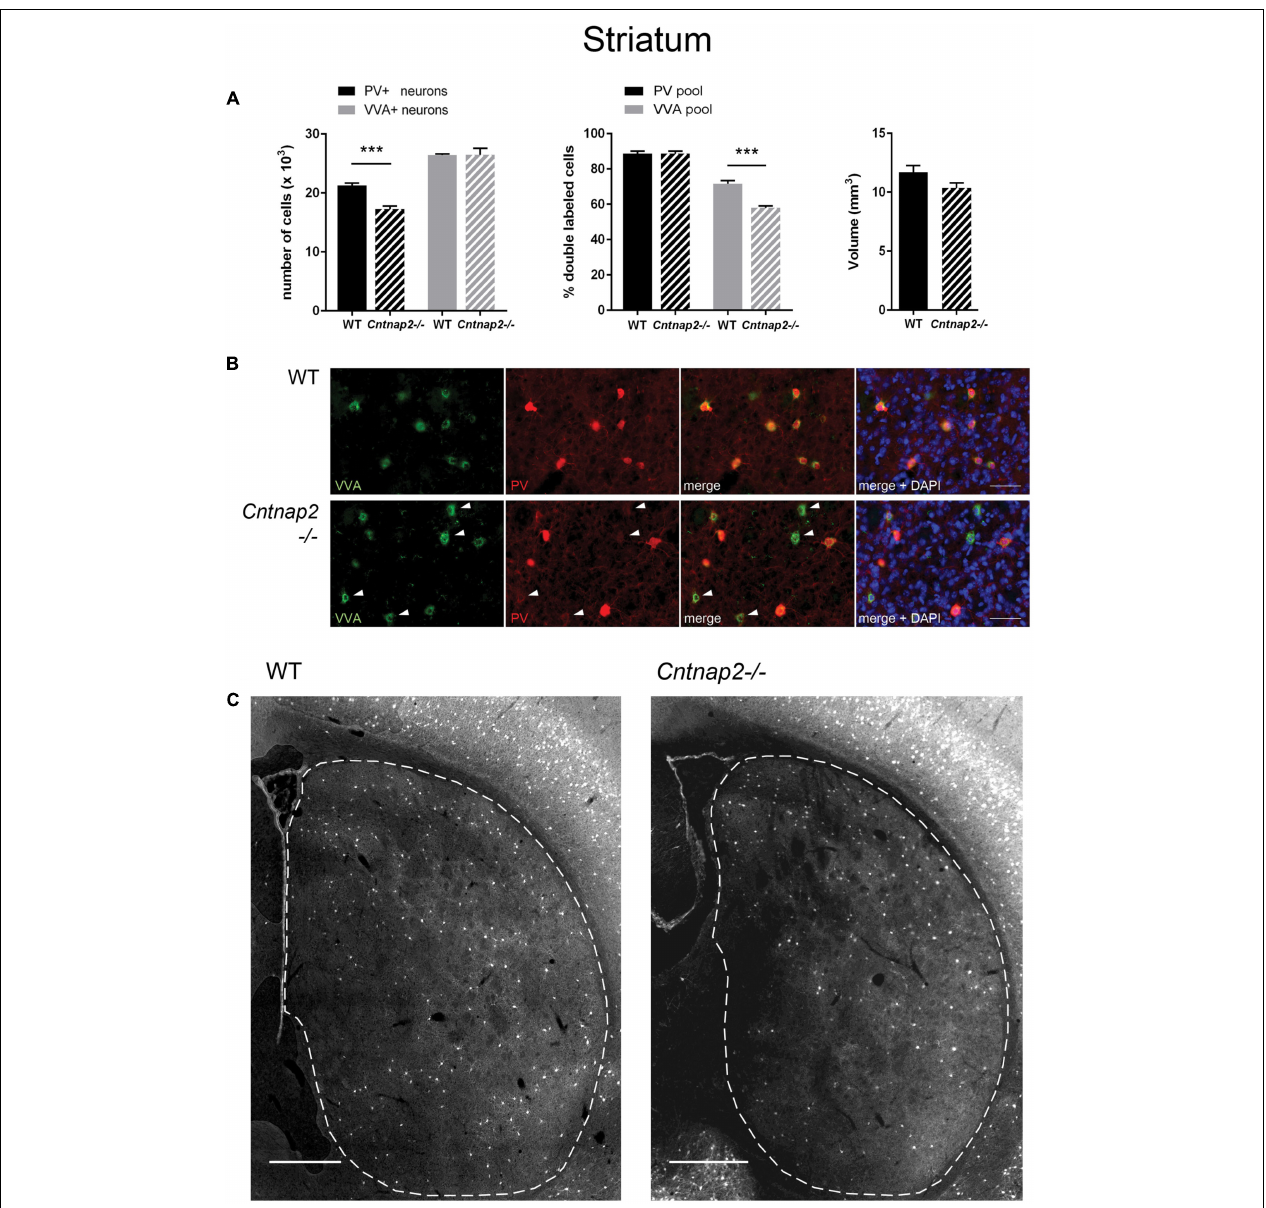
FIGURE 1 | (A) Left: Stereological estimations of PV + (black) and VVA + (gray) cells in the striatum of PND25 WT ( N = 6) and Cntnap2 − / − ( N = 5) mice. Middle: percentage of PV + cells surrounded by VVA (black) and VVA + cells showing PV expression (gray) in WT and KO mice. Right: Volume of the ROI; i.e., the striatum. Asterisks represent ∗∗∗ P < 0.001. (B) Representative immunofluorescence images of PV (red) and VVA (green) co-localization from PND25 mouse striatum are shown. Less VVA + cells are also positive for PV in Cntnap2 − / − compared to WT mice (outlined by arrowheads). (C) Representative PV immunofluorescence images from the striatum of a WT and Cntnap2 − / − mouse. ROIs are indicated with dashed lines (sections are located at Bregma 0.38 and 0.14 mm, respectively). Scale bar: (B) 50 µ m; (C) 500 µ m. All data are expressed as mean ±